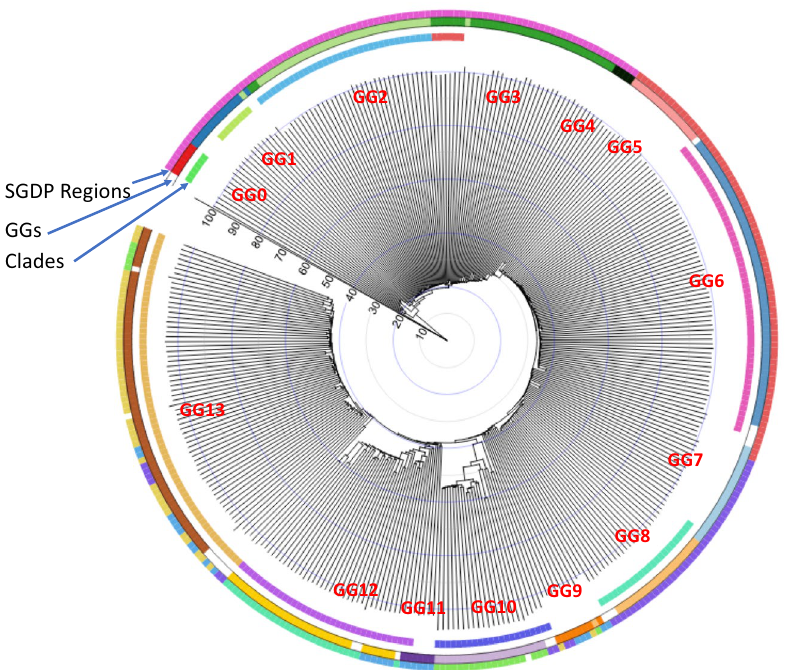
Figure 2. Rooted c-SNV-based NJ tree in circular form 15 with the “evolutionary progression scale (EPS)”. The same “distance matrix” as was used in Fig. 1 is used to construct the tree (see Rooting of c-SNV-based tree in Data Source and Methods in Supplementary Materials). “Evolutionary progression scale” is the scaled cumulative branch-length bounded such that EPS = 0.0 at the root of the tree and EPS = around 100 at the leaf nodes. Nine clades in the tree are shown in the inner circular band. Fourteen clusters (with GG labels in red) from Fig. 1 are shown in the middle band for comparison with the 9 clades of the tree. The outer band shows the regional classification used in the SGDP. The blanks on the circular bands are for those individuals with no SGDP regional assignment (outer band), not clustered among GG0-GG13 (middle band), or not in any of the 9 clades (inner band). A corresponding linear topological tree with the names of EGs is shown in Supplementary Fig.